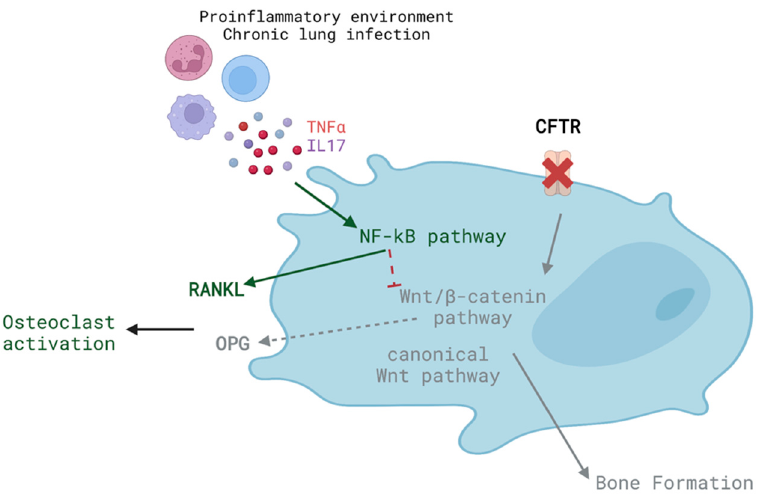
Figure 3. Defects in CFTR function hamper osteoblast maturation. Scheme was created using Bio- render.com (www.biorender.com; access on 6 December